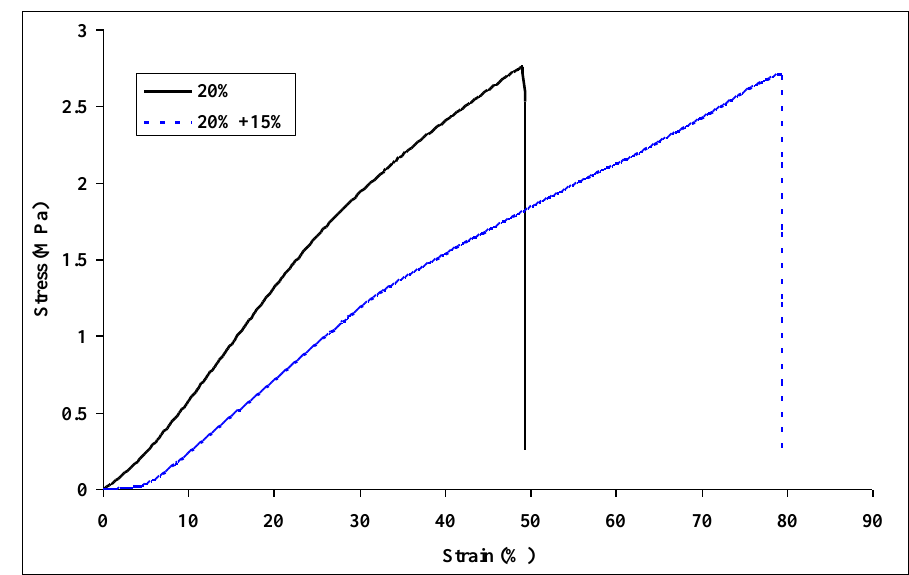
Figure 10. Typical stress-strain plots for the nylon 6 non-woven fiber mats electrospun from 20 wt %, 20 wt % and 15 wt % nylon 6 in 88% formic acid solutions. Table 5. Tensile properties of nylon 6 non-woven fiber mats electrospun from 20 wt %, 20 wt %, and 15 wt % solutions.